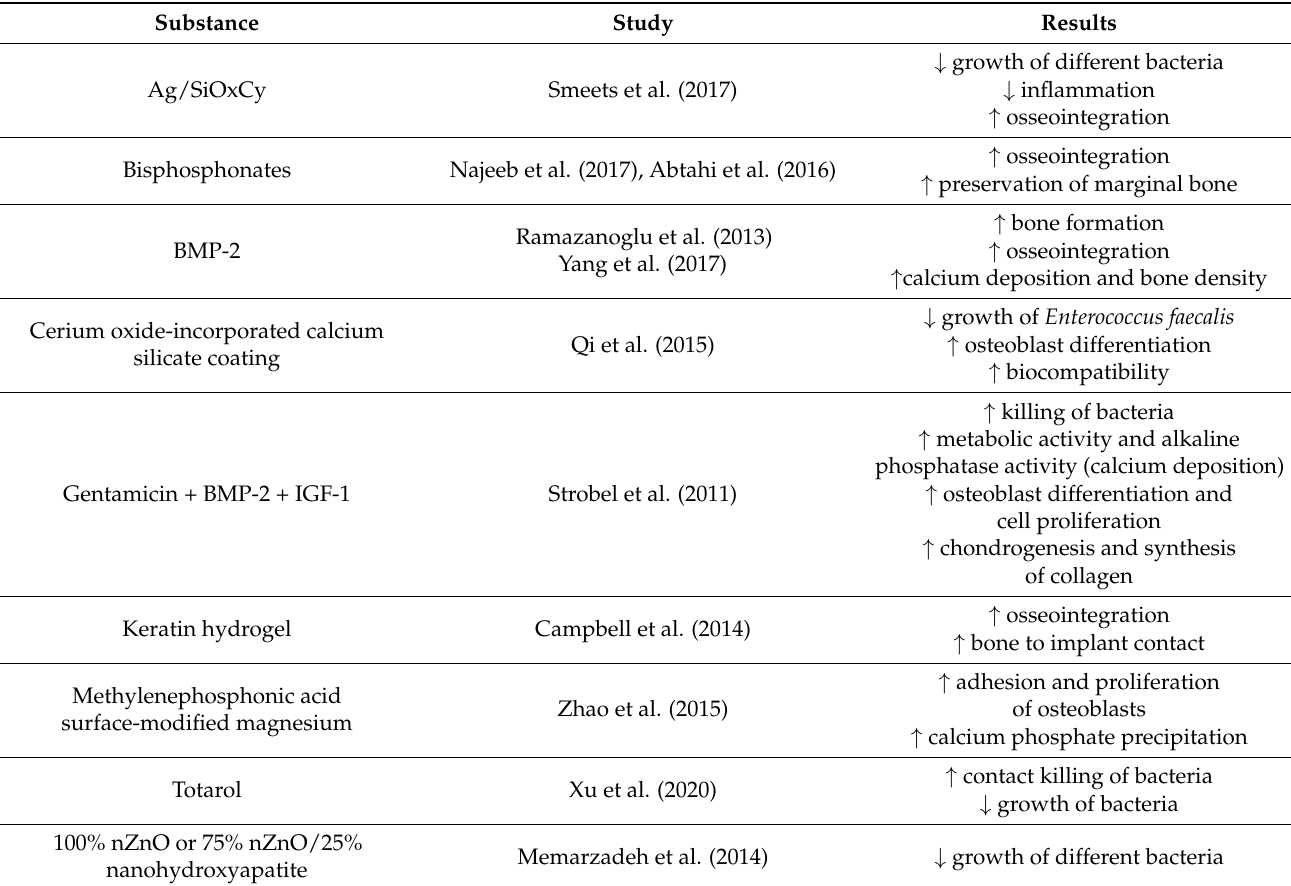
Table 1. New and old bioactive substances coating dental implants and their positive impact on an implant environment. Substance Study